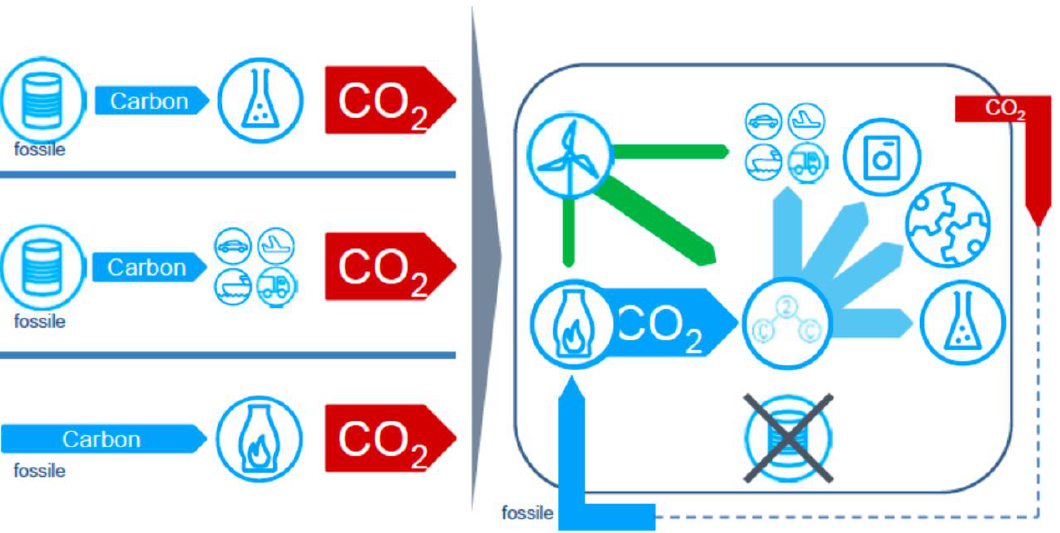
Figure 30. The Carbon2Chem project (source: ThyssenKrupp Steel). Metals 2019 , 9 , x FOR PEER REVIEW